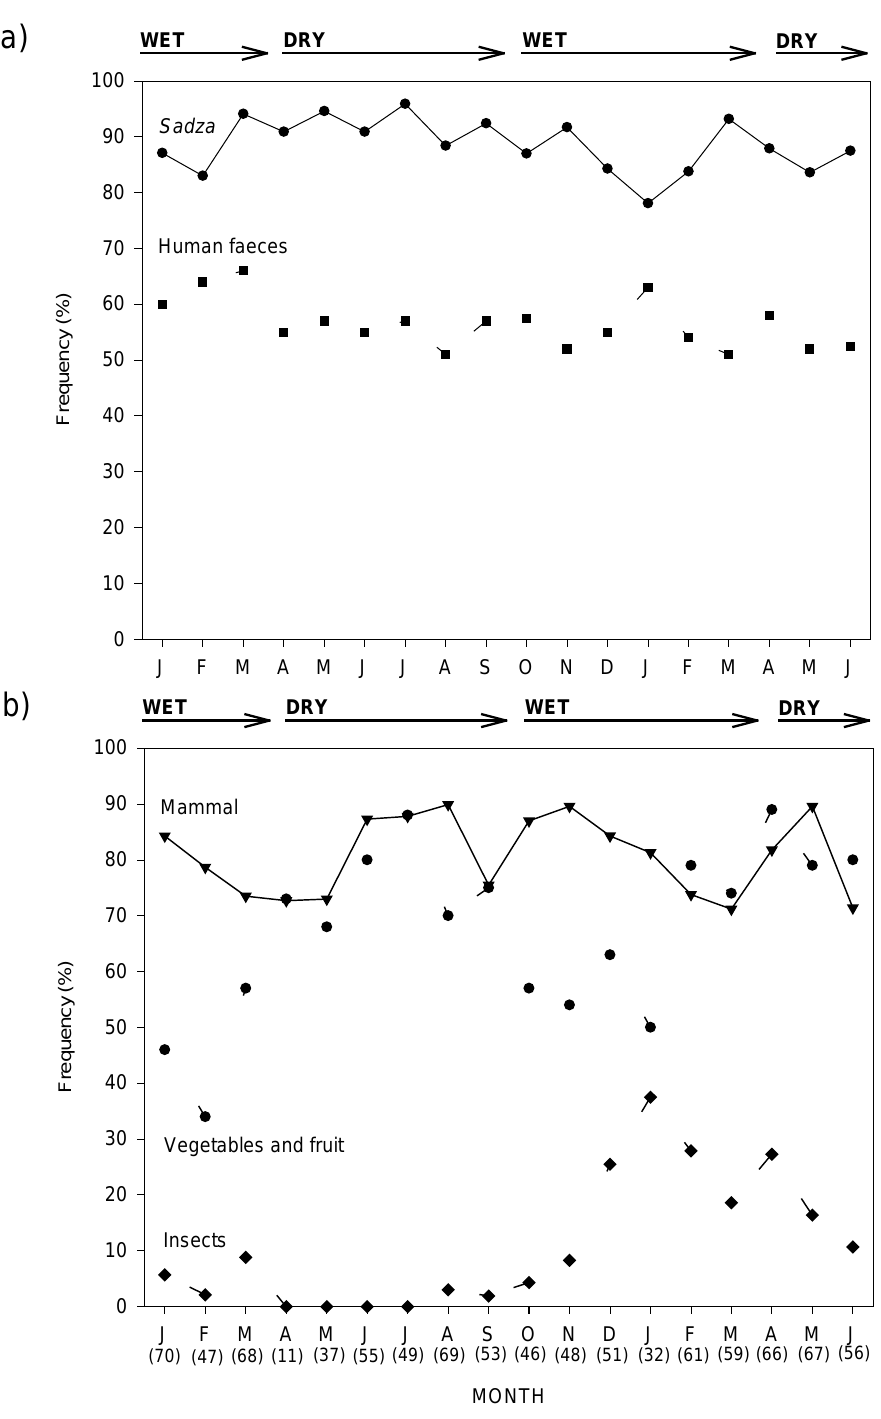
Figure 3. Monthly (January 1995–June 1996) percentage frequency of occurrence in dog scats of ( a ) sadza and human faeces, and ( b ) mammalian remains, vegetables and fruit, and insects, through dry and wet seasons. Numbers in brackets indicate the monthly sample size of scats analysed.